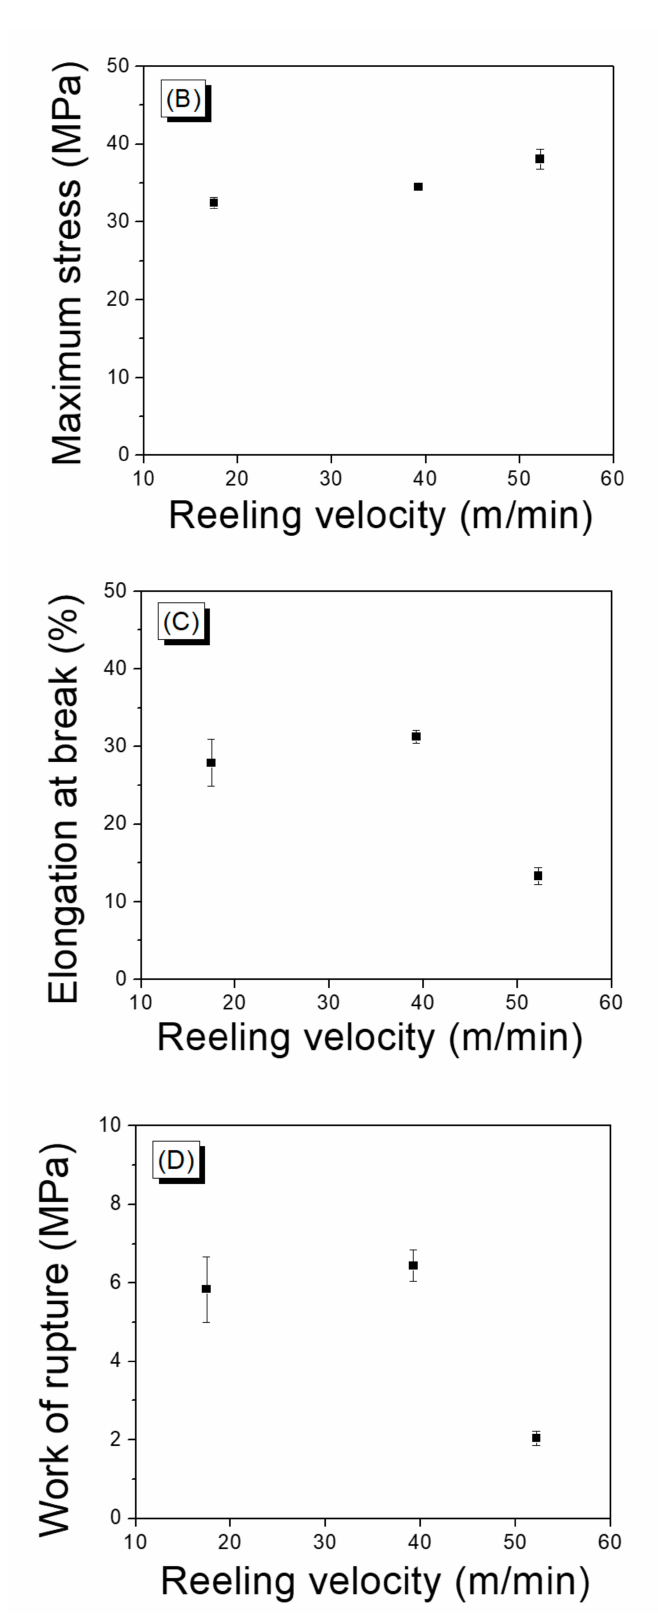
Figure 3. ( A ) Representative stress–strain curve, ( B ) tensile strength, ( C ) elongation at break, and ( D ) work of rupture determined for silk web prepared at various reeling velocities. Reeling bath temperature was 50 ◦